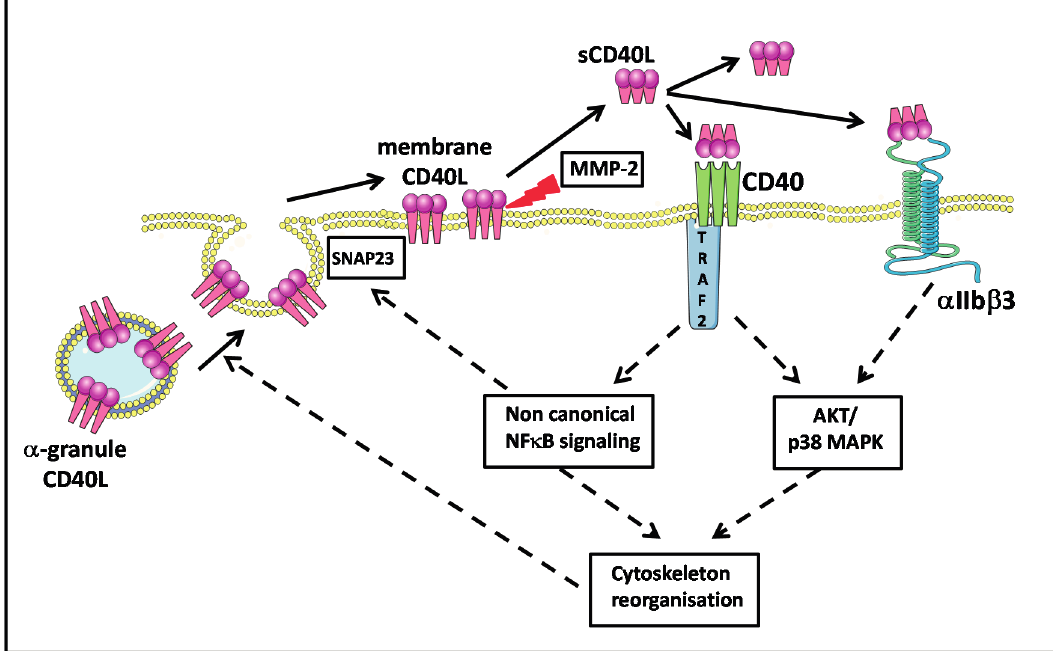
Figure 3. Schematic overview of the regulation of platelet CD40L and the role of sCD40L in signaling after binding to platelet CD40 and α IIb β 3 inducing an auto-amplification loop. Synaptosomal-associated protein 23 (SNAP23), mitogen-activated protein kinase (MAPK), nuclear factor kappa B (NF- κ B), protein kinase B (AKT)